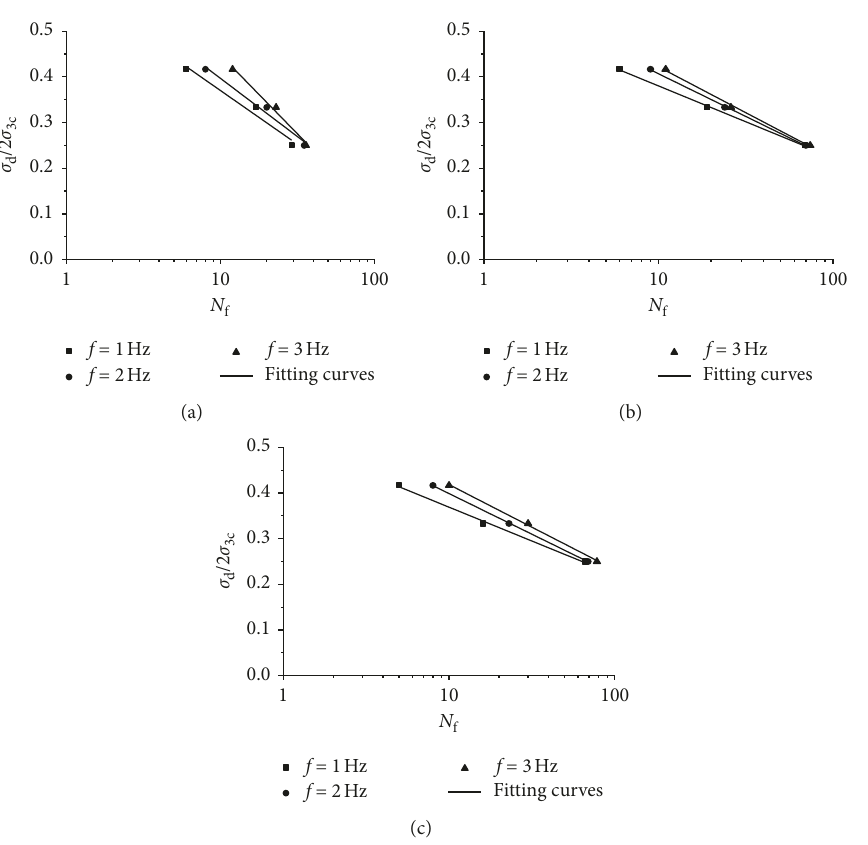
� 50kPa; (b) σ � 100 kPa; (c) 3c 3c